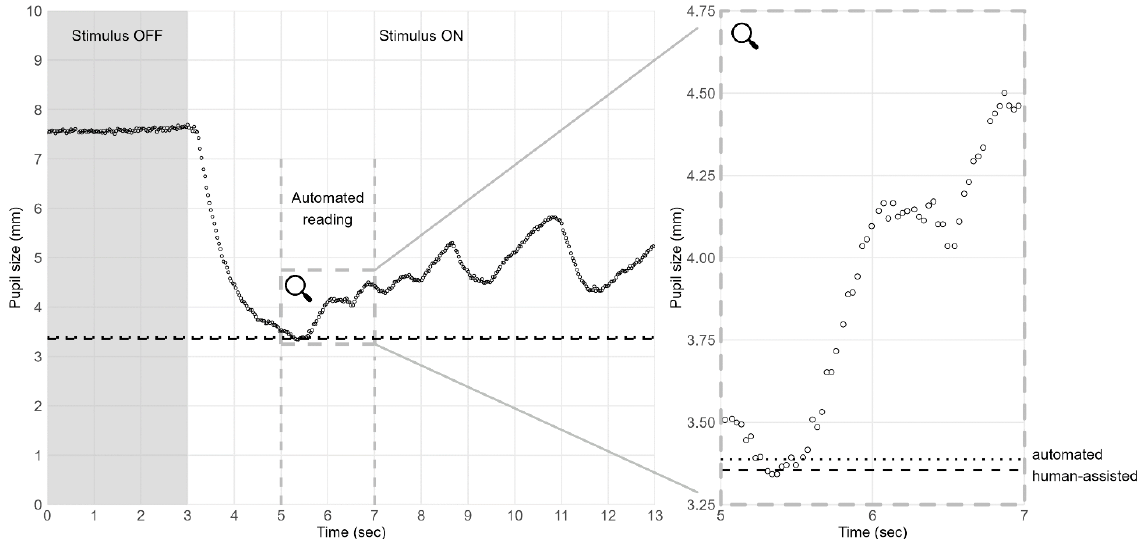
Figure 1. The inherent difference between human-assisted and automated readings. Notes: An example of continuous pupil size measurement over time under mesopic conditions. Pupil size is plotted during 3 s of darkness (Stimulus OFF) and 10 s of light (Stimulus ON). The pupil size decreases from about 7.5 mm to about 3.4 mm (3 to 5.5 s), escapes to larger size (5.5 to 8.5 s) and oscillates at about 5 mm (8.5 to 13 s). Vertical dashed lines indicate the 2-s interval of automated reading. Magnified insert highlights the inherent difference between reading methods as the automated reading (horizontal dotted line) was configured to report a 10% percentile, whereas the human-assisted reading (horizontal dashed line) allowed for reporting the minimum pupil size based on a single data point. Abbreviations: sec = second.